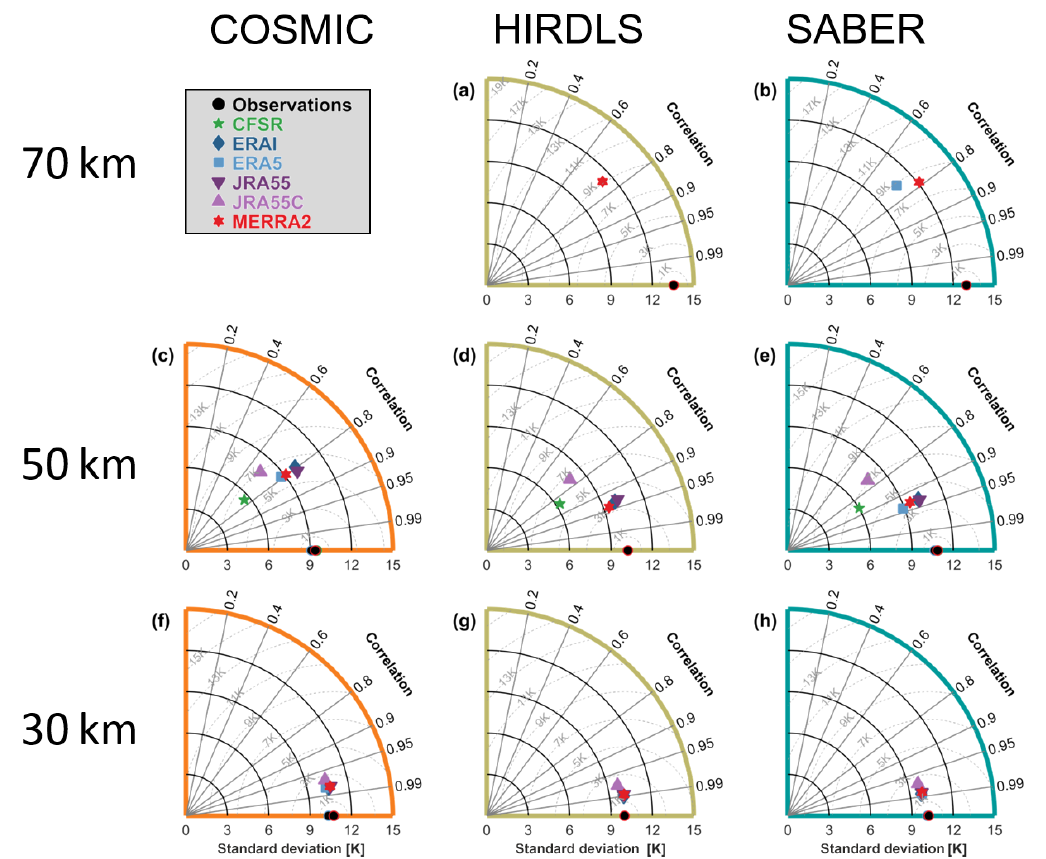
Figure 10. Taylor diagrams for each reanalysis–instrument pairing. For each panel, the radial axis shows the standard deviation of each sampled-reanalysis dataset (indicated by coloured symbols), and the curved axis indicates the correlation of that dataset with the equivalent observational dataset. Black circles indicate the observational datasets themselves, which by definition perfectly autocorrelate. Grey arcs show the root-mean-square difference between the observational and sampled datasets. Multiple black circles are plotted on each panel and outlined with colours; this is because each reanalysis covers a slightly different time range, and thus there is a small amount of variability in the observational standard deviation; RMSD arcs are based upon the MERRA-equivalent observational standard deviation in each case (i.e. the red outlined circles). Each row shows a different height level, and each column a different